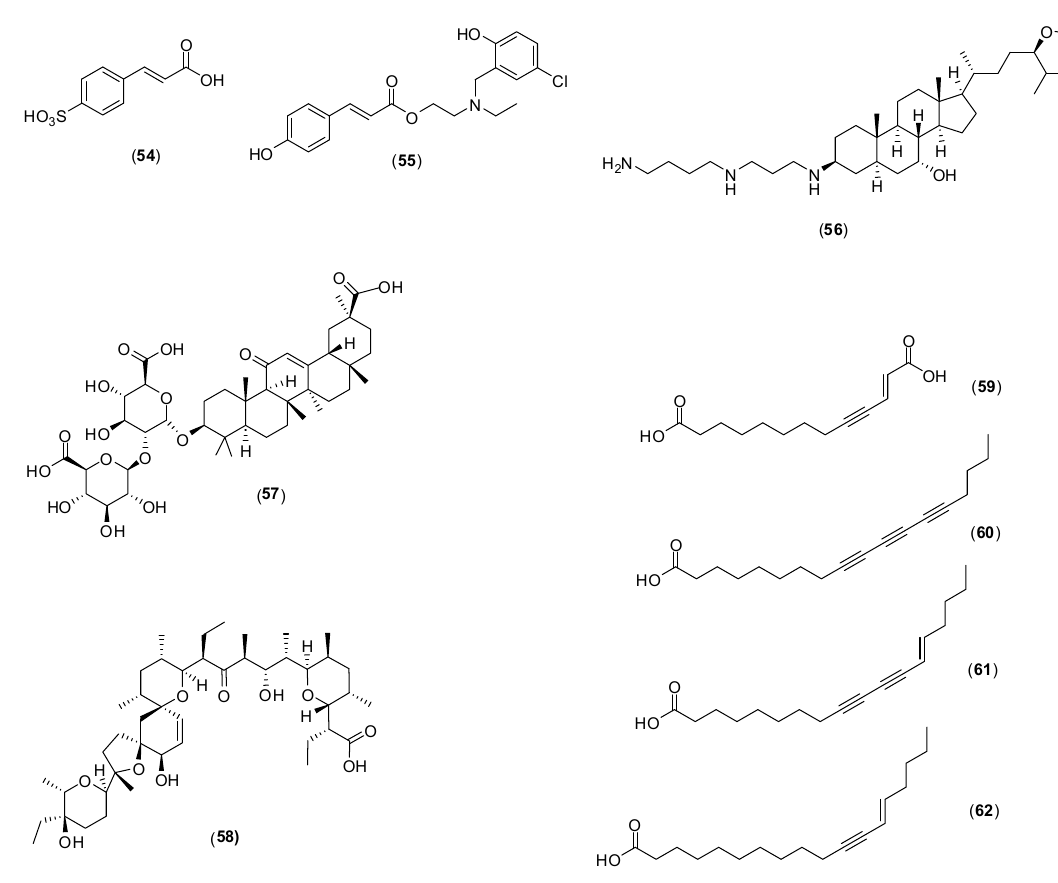
Figure 23. Structures of compounds 54 – 62 .